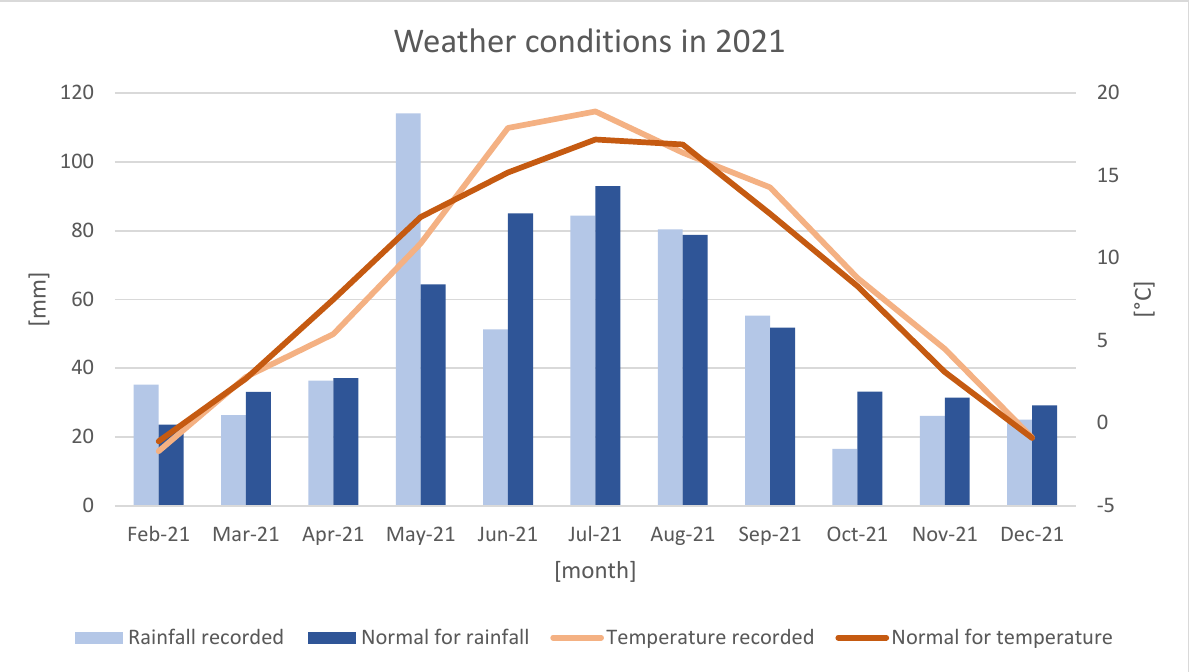
Figure 5. Average monthly temperatures and precipitation in the area of Szalejów Górny in 2021 as compared to the normal [51].